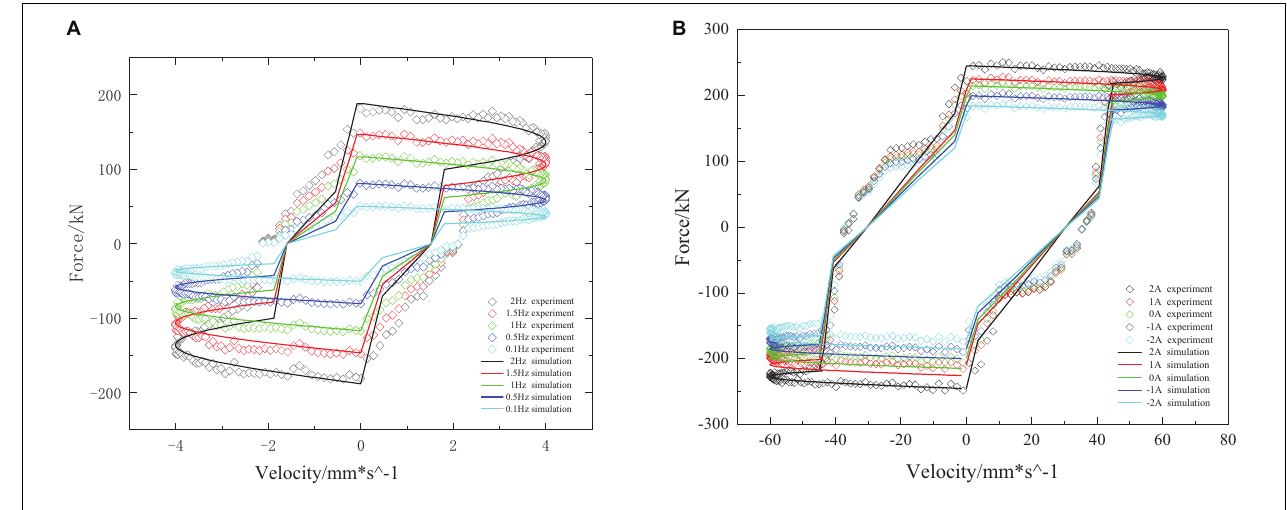
FIGURE 9 | Force–velocity relationship curves: (A) small displacement and (B) large